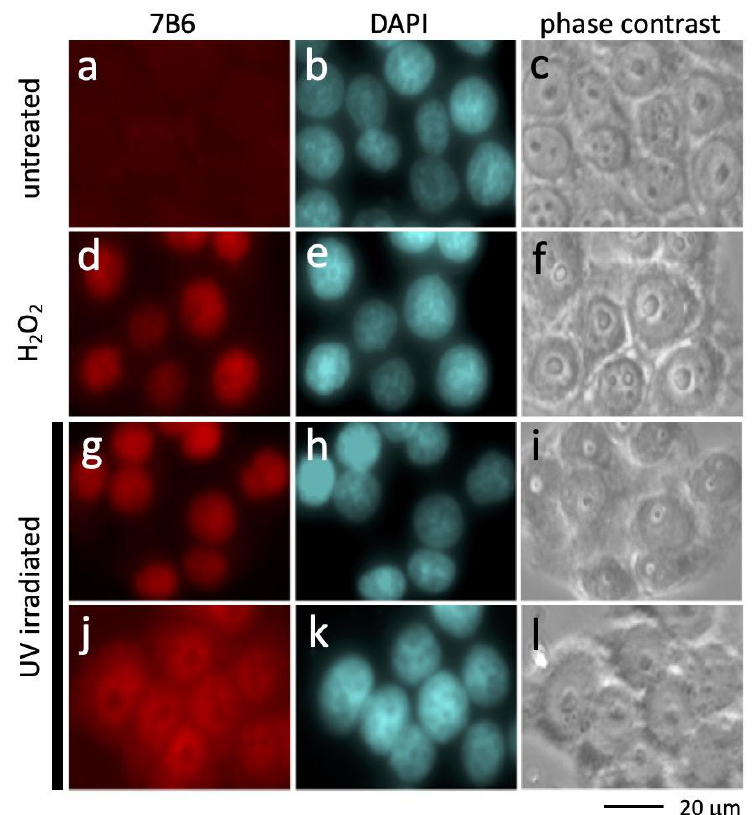
Figure 1. Translocation of La protein to the cytoplasm after UV irradiation. Fixed cells were stained with ( a ) the anti-La mAb 7B6 or ( b ) DAPI. ( c ) Phase-contrast image. ( d ) Prior to the staining with the anti-La mAb 7B6 La protein was oxidized by washing the fixed cells with PBS containing H 2 O 2 . ( e ) DAPI staining of fixed cells. ( f ) Phase-contrast image. ( g ) Cells were UV irradiated. Nine min after irradiation, the cells were fixed and stained with the anti-La mAb 7B6. ( h ) DAPI staining of fixed cells. ( i ) phase-contrast image. ( j ) Cells were UV irradiated. Two h after irradiation, the cells were fixed and stained with the anti-La mAb 7B6. ( k ) DAPI staining of fixed cells. ( l ) Phase contrast